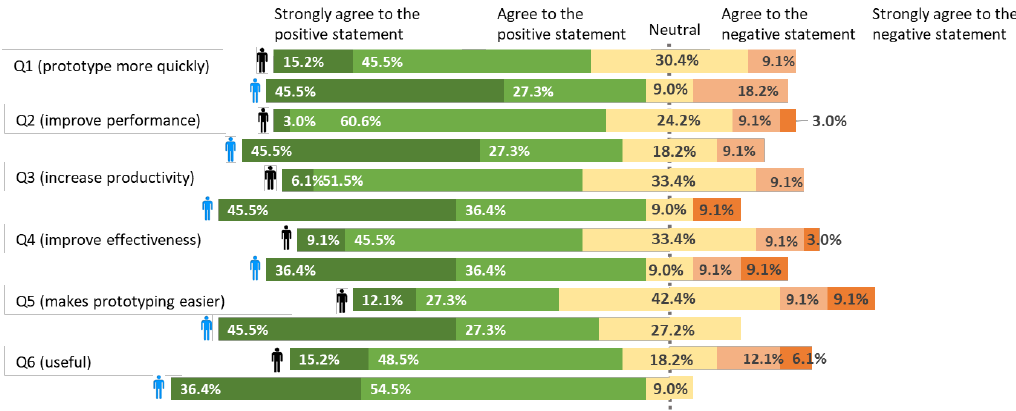
Fig. 15. Perceived usefulness of USINN as basis for creating mockups.